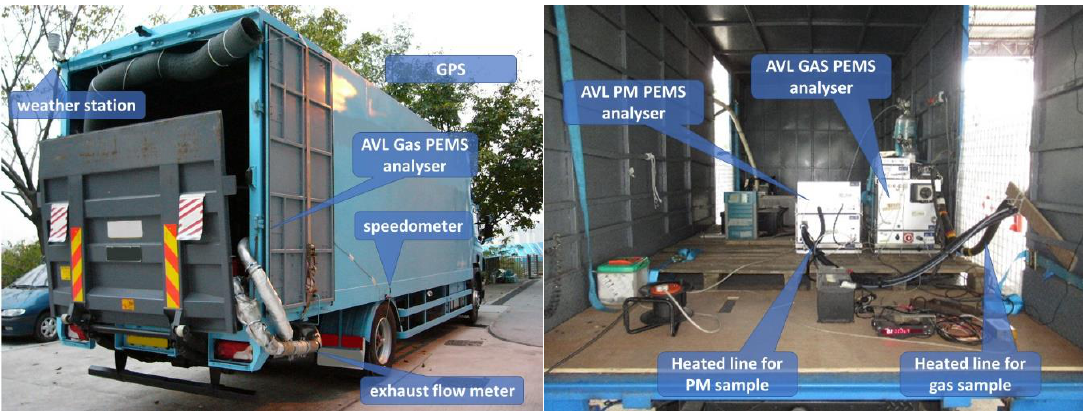
Figure 2. HDDT in test setup configuration. Left photo: GPS (global positioning system), SEMTECΗ EFM-2 or EFM-HS flowmeter (Sensors, Inc., USA), AVL M.O.V.E. GAS/PM PEMS analyzers, speedometer (Peiseler GmbH, Germany), weather station. Right photo: AVL M.O.V.E. GAS PEMS and AVL M.O.V.E. PM PEMS.